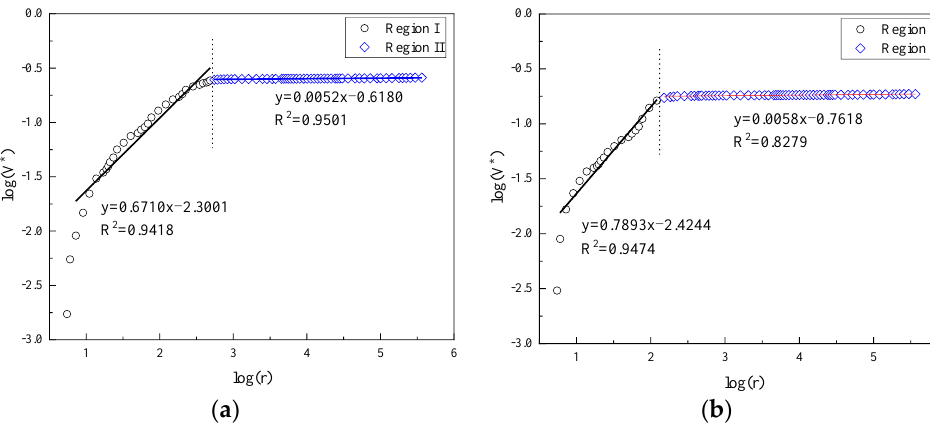
Figure 9. Multifractal characteristics of OCP0 at different ages under Ji’s model. ( a ) 3 days, ( b ) 28 days.